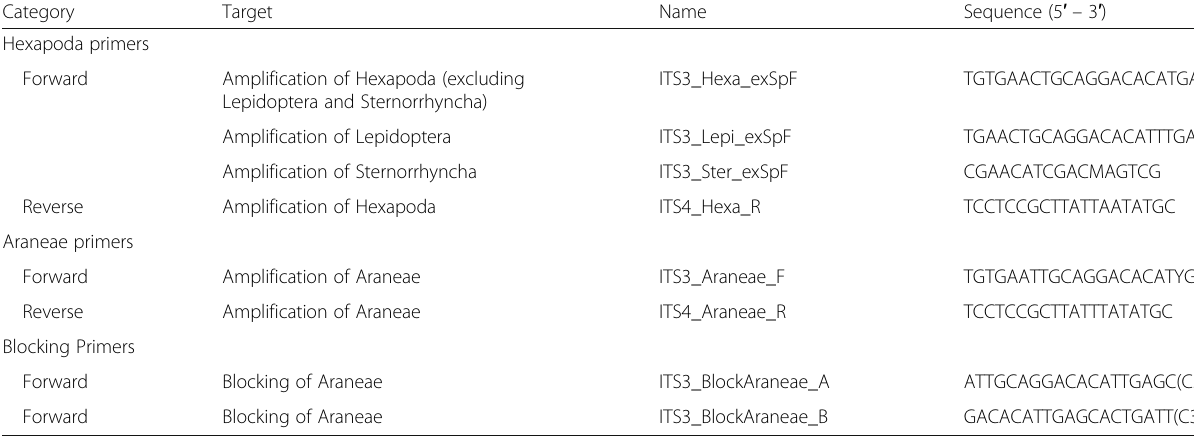
Table 1 PCR primers developed in this study. Hexapoda-specific and Araneae-specific primers were developed at a 5.8S rRNA position involving deletions/insertions (Fig. 1). Reverse primers were designed at the 5 ′ -end of 28S rRNA region. A C3 spacer was added to the 3 ′ -end of each blocking primer for the selective amplification of